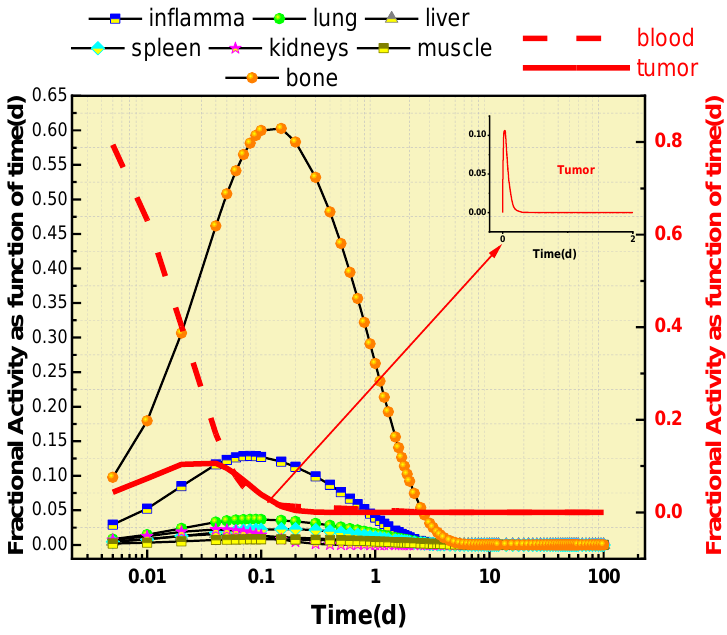
Figure 5. Activity fraction of 89 Zr-oxalate as a function of time for some organs.